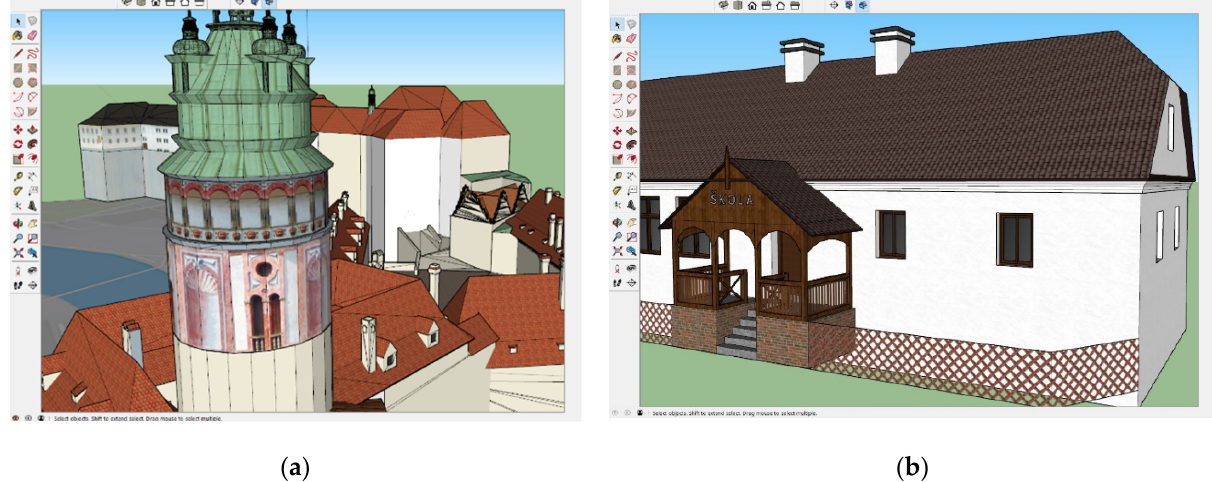
Figure 8. Manual 3D modelling in CAD software (Trimble SketchUp): ( a ) Č eský Krumlov Castle; ( b ) disappeared school building in the parish complex in Č ervená nad Vltavou.